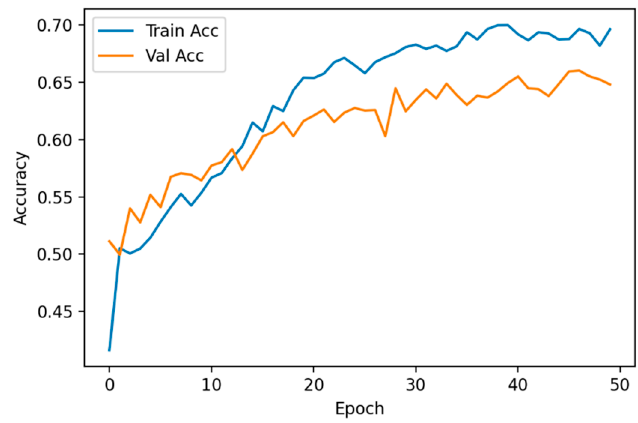
Figure 5. Evolution of the accuracy for the training set and the validation set.